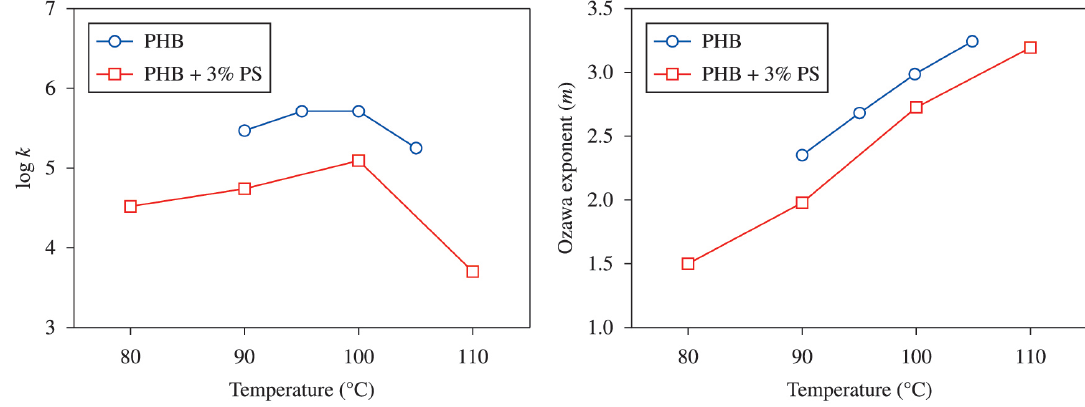
Figure 5. Ozawa parameters, Equation (4) , for PHB and a PHB/PS blend with 3% PS.